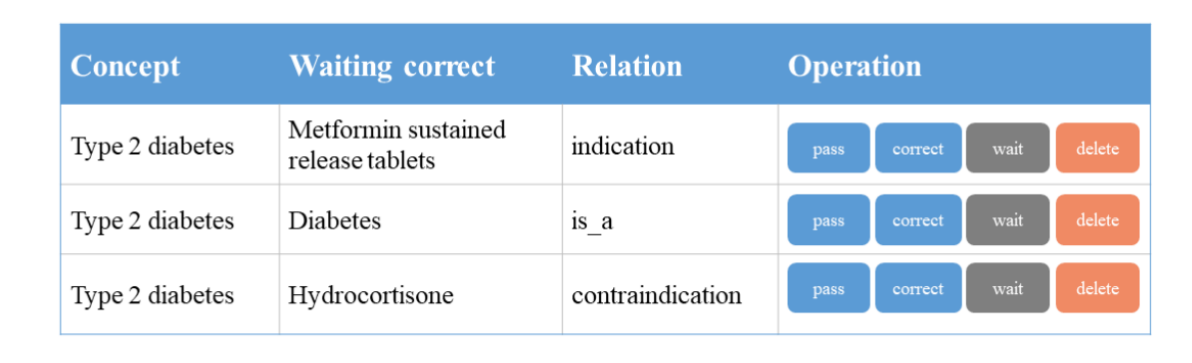
Figure 9. Design of the knowledge correction system. We examined the information extracted automatically, corrected the errors, and included the information in the medical knowledge graph, which was made available for the next round of information extraction and downstream